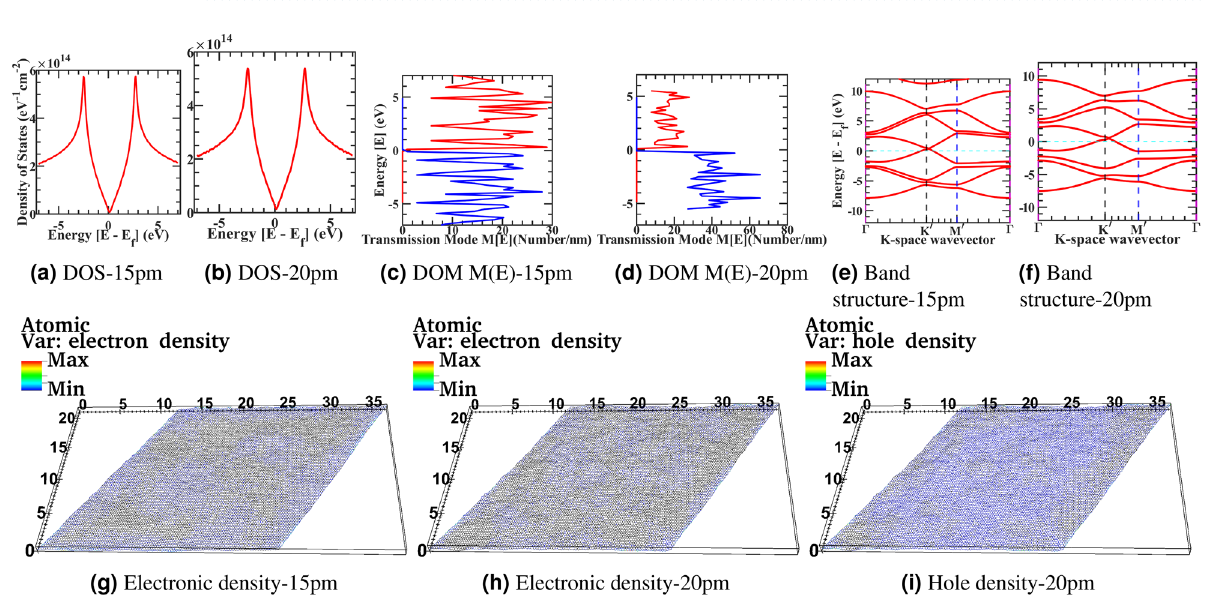
Figure 3. Device structure 100x100 graphene supercell with surface corrugation 15pm and 20pm, and respectively Density of state ( a , b ), Electronic density of modes M(E) in x-y Direction ( c , d ), Electronic band structure ( e , f ), Electronic density ( g , h ), and Hole density ( i ) at